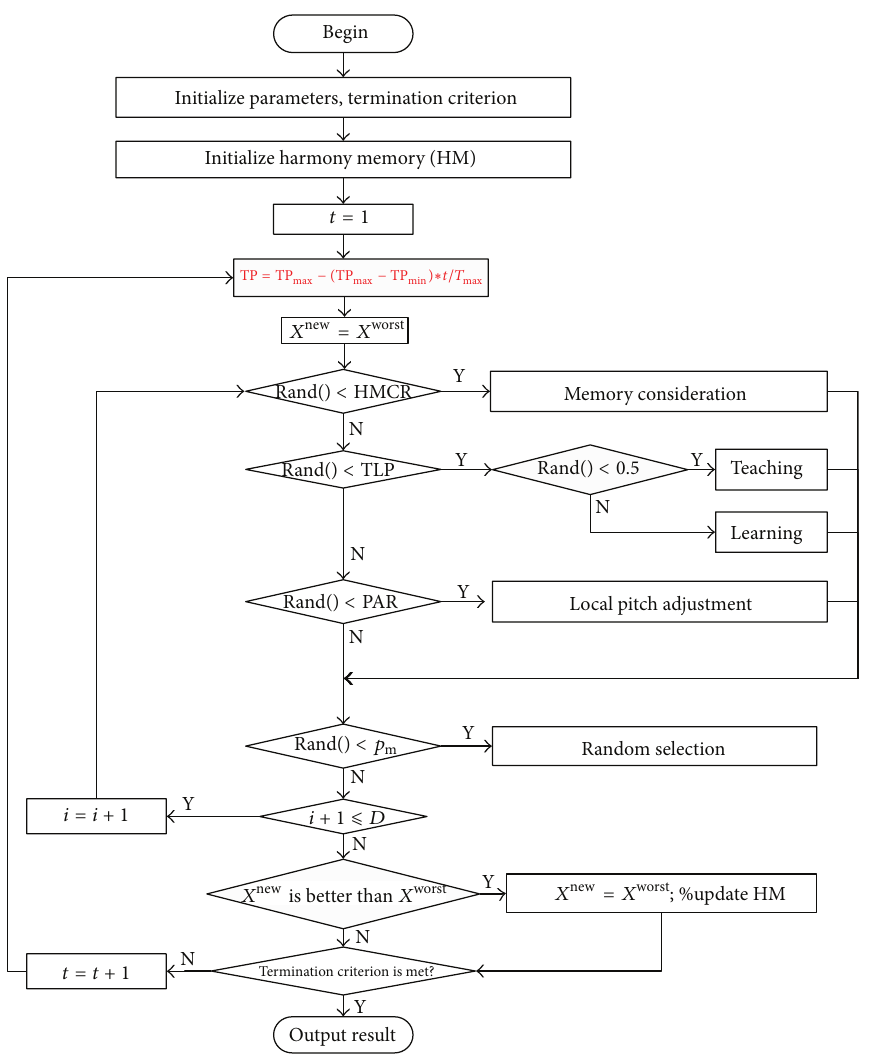
Figure 2: The flowchart of HSTL